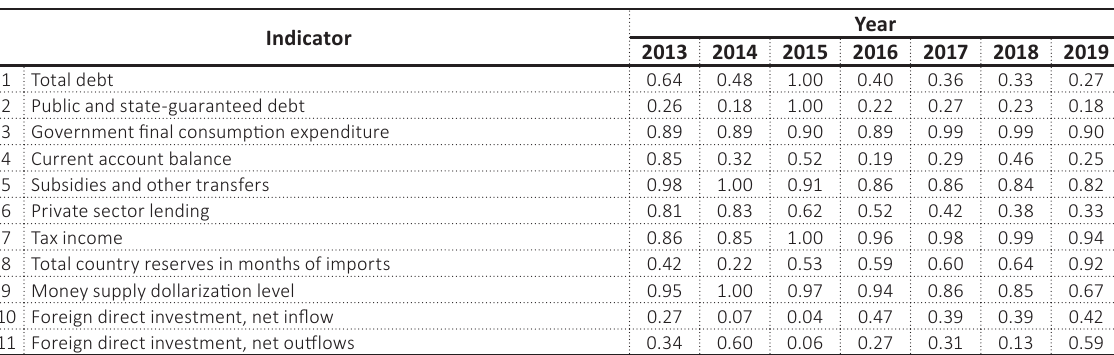
Table 5. Normalized direct impact indicators in terms of assessing Ukraine’s financial security Source: Own calculations based on World Bank databases.